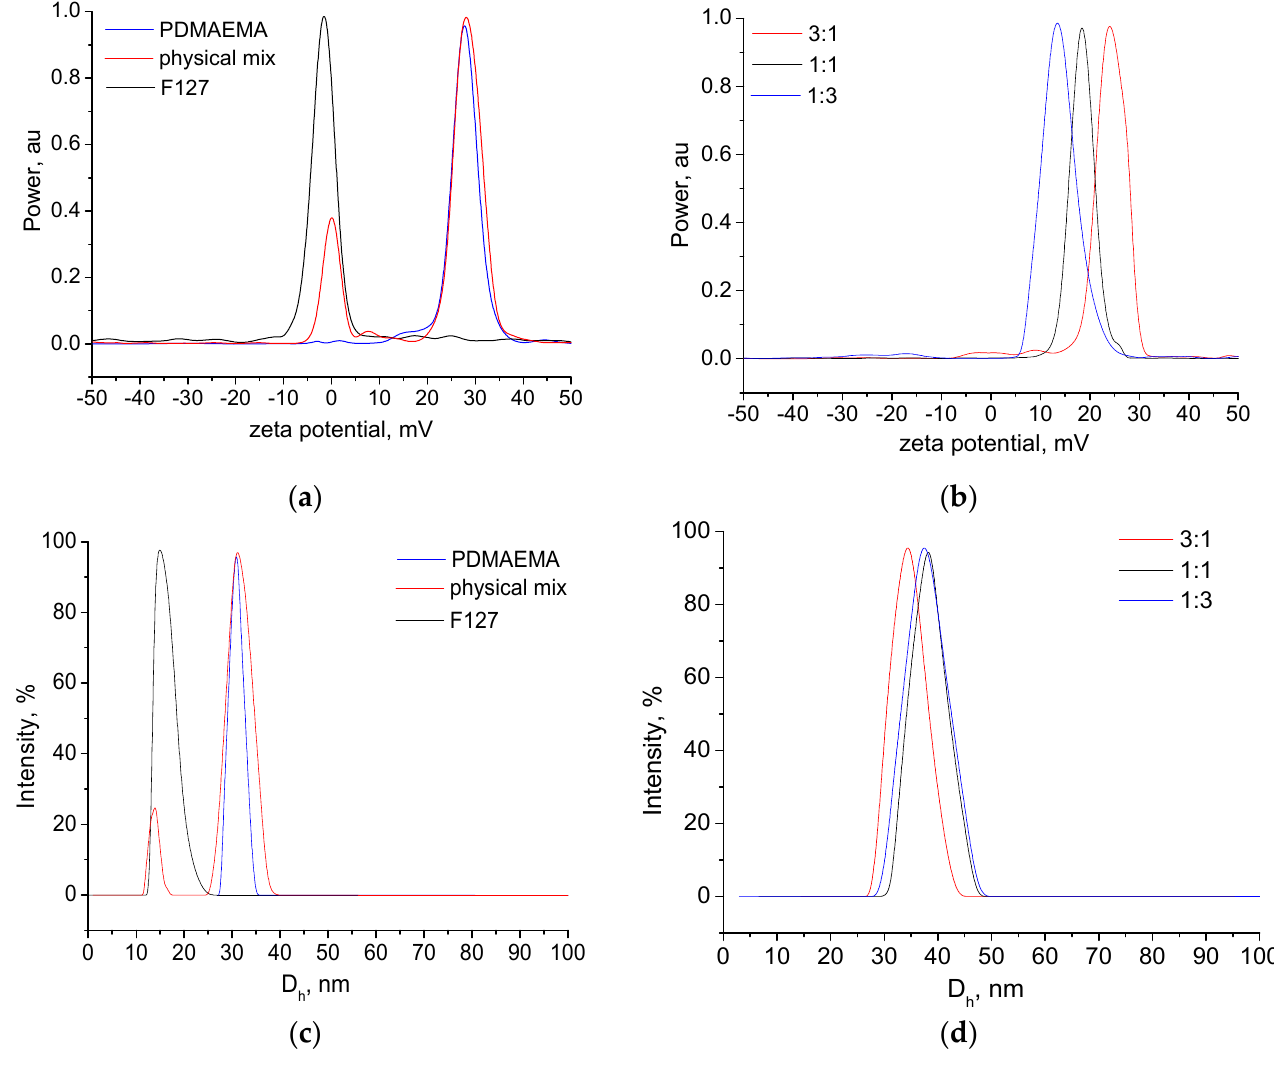
Figure 1. ζ -potential ( a , b ) and size ( c , d ) distribution curves of SCPMs, their physical mixture, and MPMs prepared at di ff erent molar ratios. All measurements were conducted at concentration of 1 mg·mL − 1 and 25 °C.